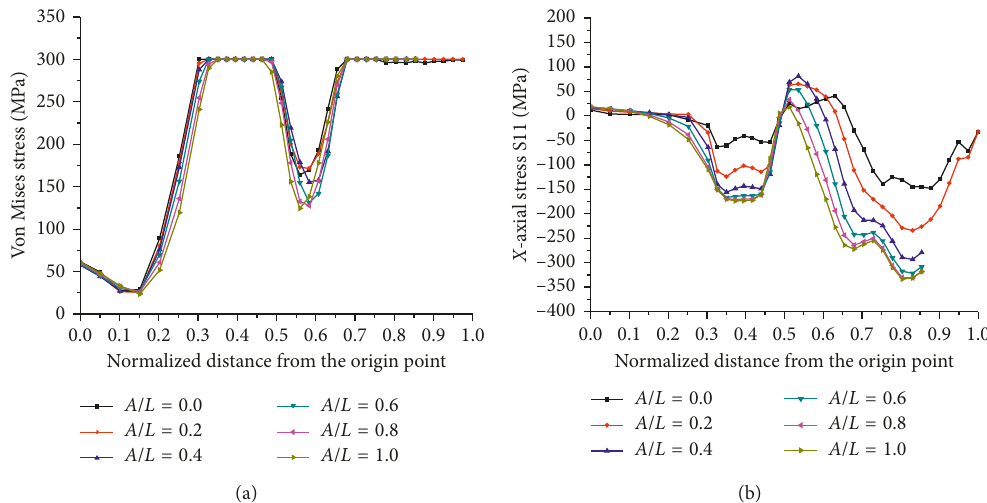
Figure 16: Mises stress and S11 stress distribution curves of the wedge-shaped part of the joint. (a) Equivalent stress distribution curve. (b) X-axial stress distribution curve.